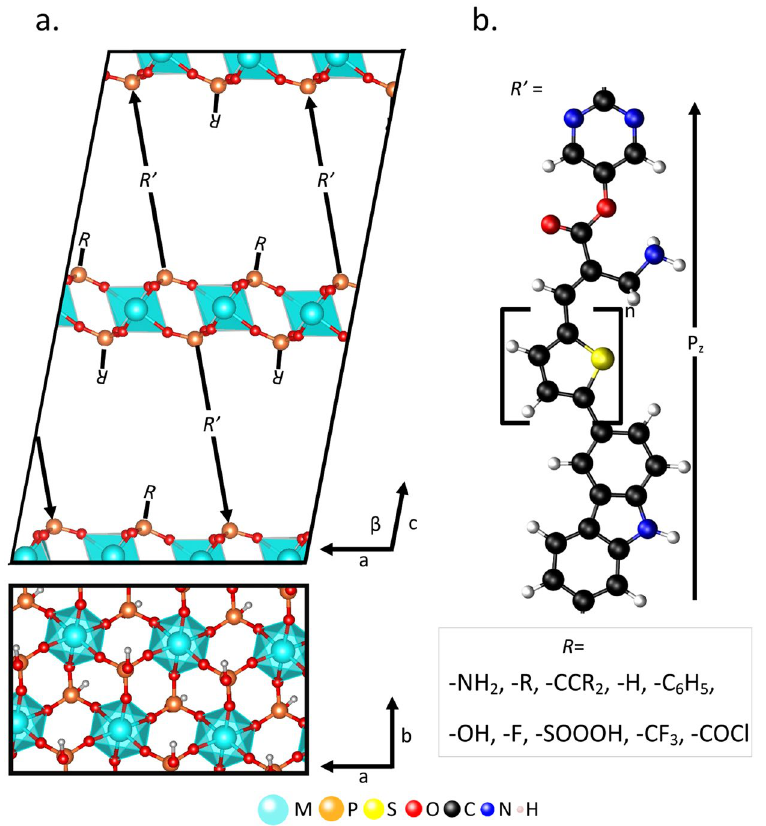
Figure 2. Schematic illustrating the range of structures studied in this work. ( a ) Top, side view of supercell with R’ molecules. Arrows show the direction of molecular dipoles. Bottom, in-plane view of TMP with R = -OH. ( b ) Representative molecule of R’ studied in this